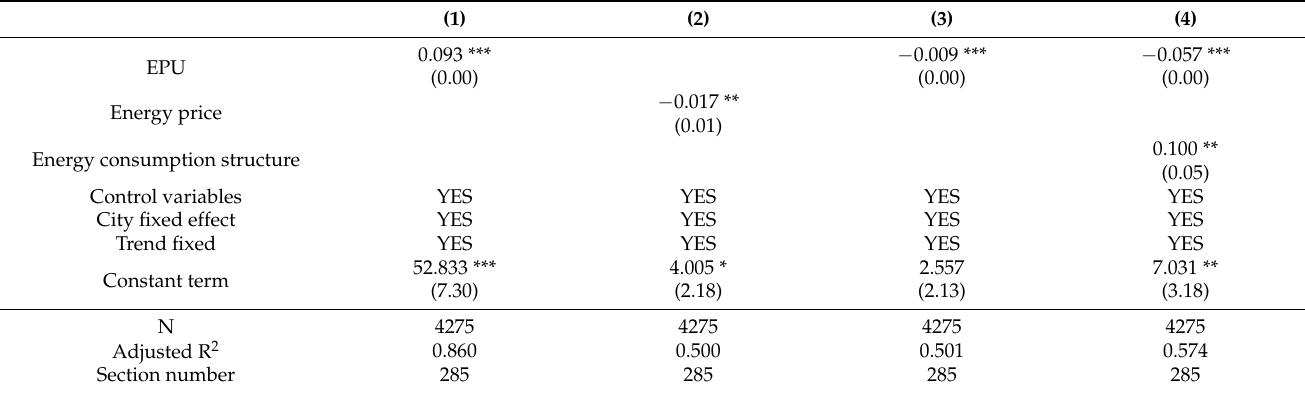
Table 6. Energy market adjustment mechanism.